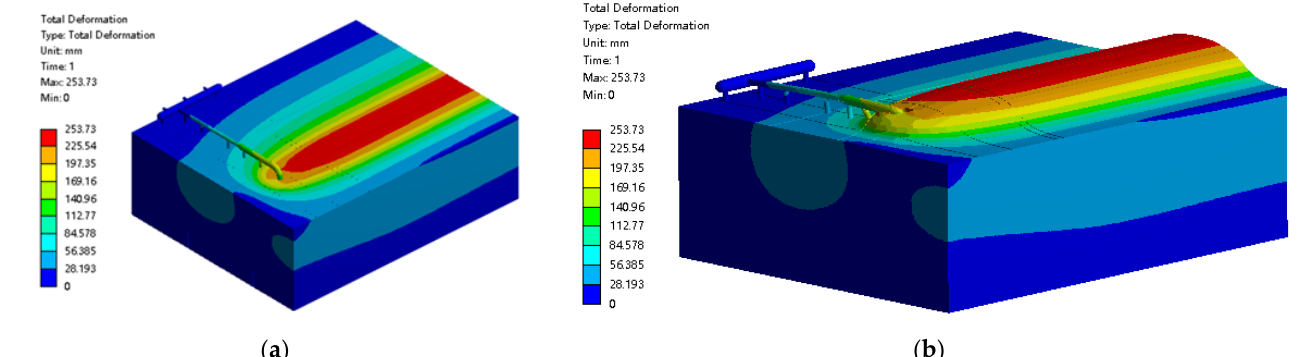
Figure 7. Overall frost heave damage diagram of buried pipeline and its surrounding soil: ( a ) cloud diagram of frost deformation of pipe–soil structures; ( b ) isometric cloud diagram of the frost defor- mation of the pipe–soil structure.